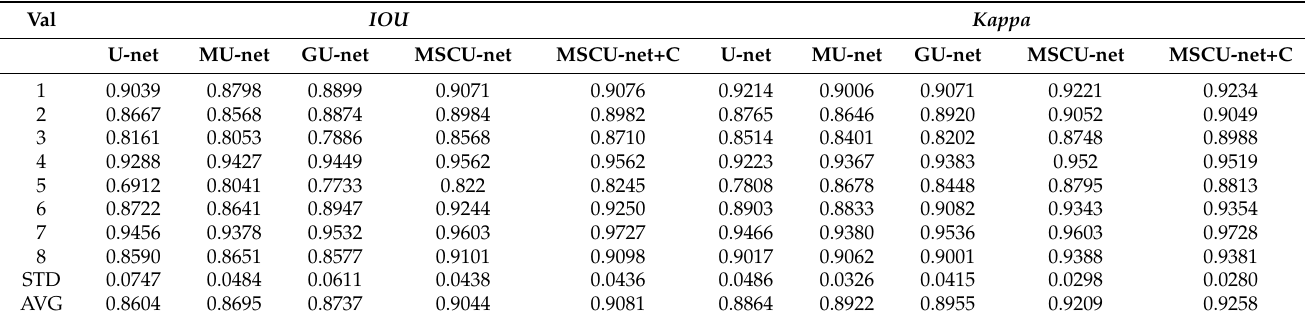
Table 3. Comparison of ablation experiments on pixel-wise classification.